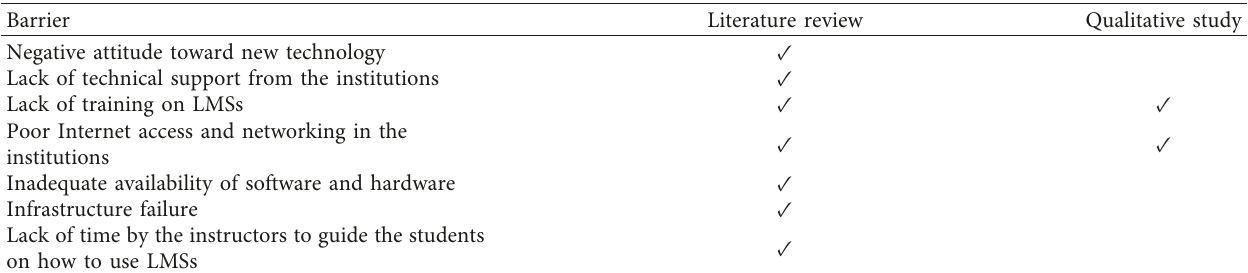
Table 3: Comparative analysis of the barriers of using LMSs between the literature review and the questionnaire results.